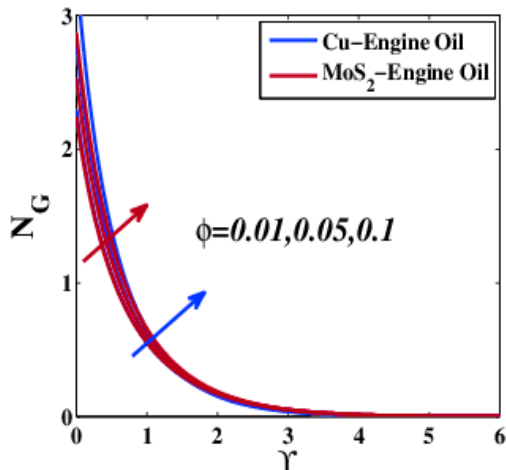
Figure 14. Temperature variation 𝜃(𝛶) under the influence of 𝜙 .